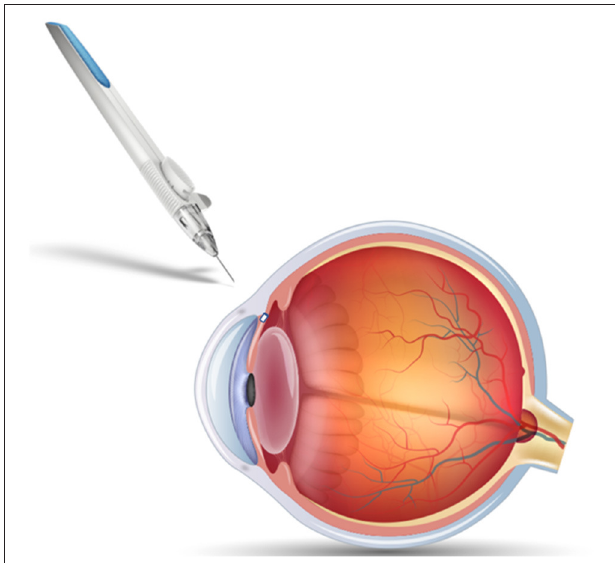
FIGURE 2 | Schematic of Durysta® intracameral implant and applicator. The PLGA-based insert allows extended release of bimatoprost for treatment of open-angle glaucoma, overcoming some of the challenges associated with frequent eyedrop